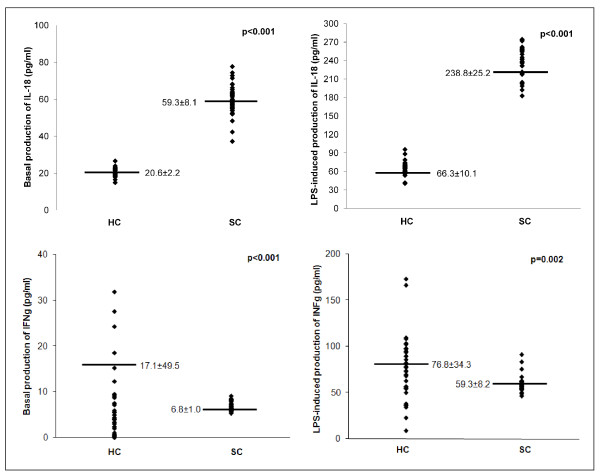
Comparison of cytokine production between SC patients and healthy controls. IL-18 and IFN-γ release by non-stimulated and LPS-stimulated PBMC (pg/ml/106 cells) from 40 healthy controls (HC) and 51 schizophrenic (SC) patients. Supernatants were collected, stored at -80°C until analysis than measured for IL-18 and IFN-γ concentration using a commercial enzyme-linked immunosorbent assay (ELISA). All samples for a given assay were analyzed in duplicate at the same time. The ELISA values (in duplicates for each sample) have an error range lower than 10%. The variation coefficient of both inter-assay and intra-assay was <5%. Each data point represents the release of IL-18 and IFN-γ from each patient. Horizontal bars indicate group mean values.